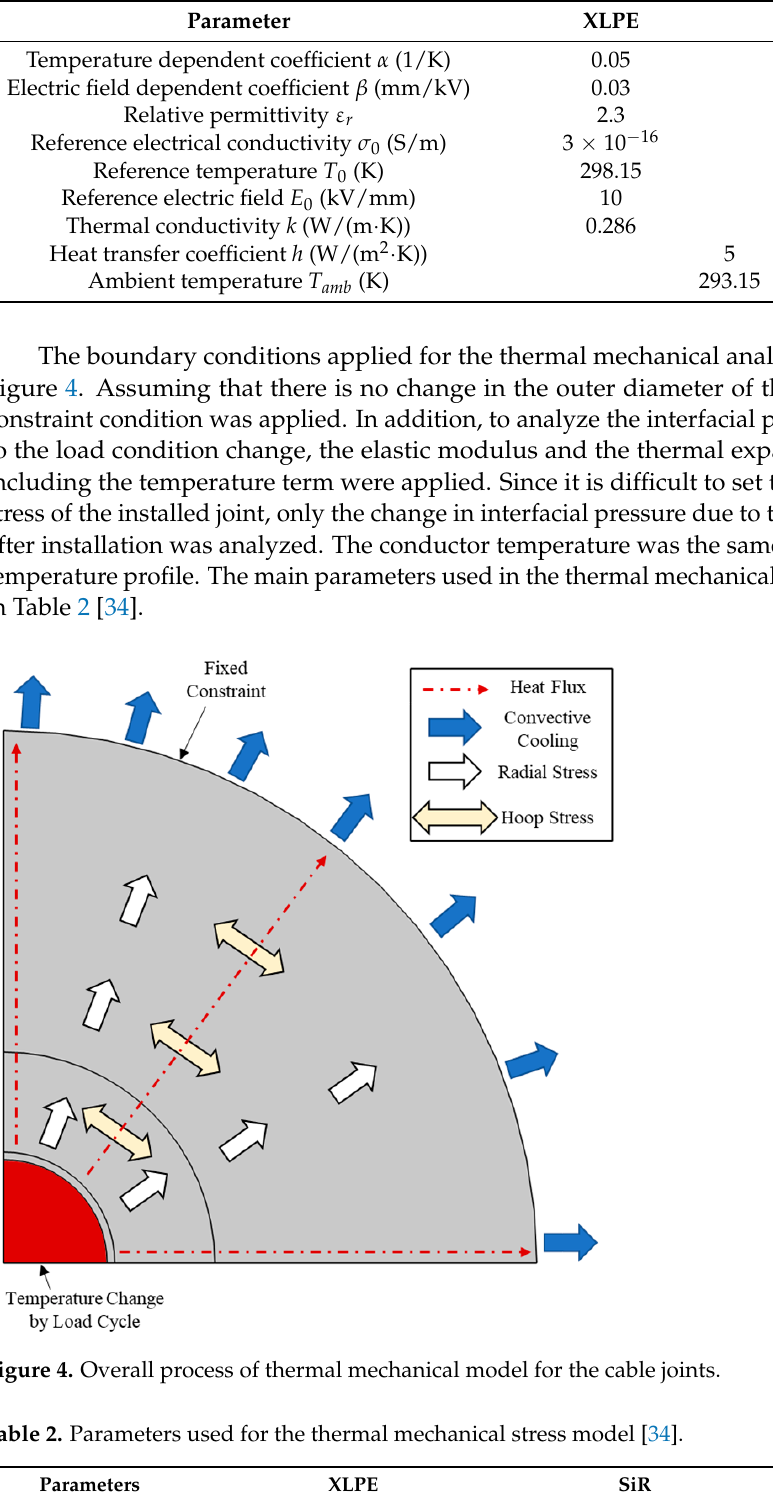
Table 1. Parameters used for the thermal electrical model [32,33].